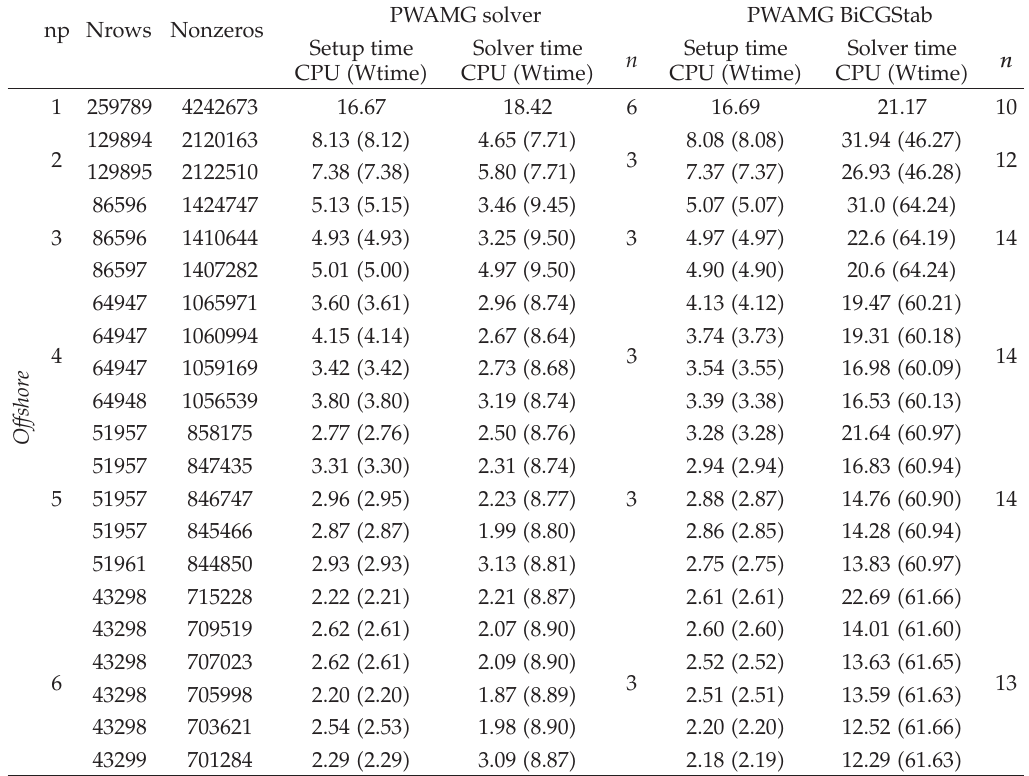
Table 4: Parallel results for o ff shore